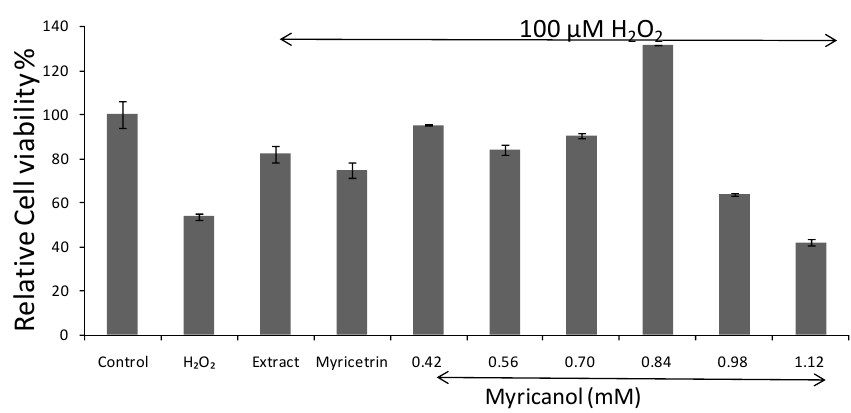
Figure 5. Effect of the whole extract (20 μ g/mL), myricetrin (0.65 mM) and myricanol at various concentrations on H 2 O 2 -induced oxidative stress in N2a cells by MTT assay.